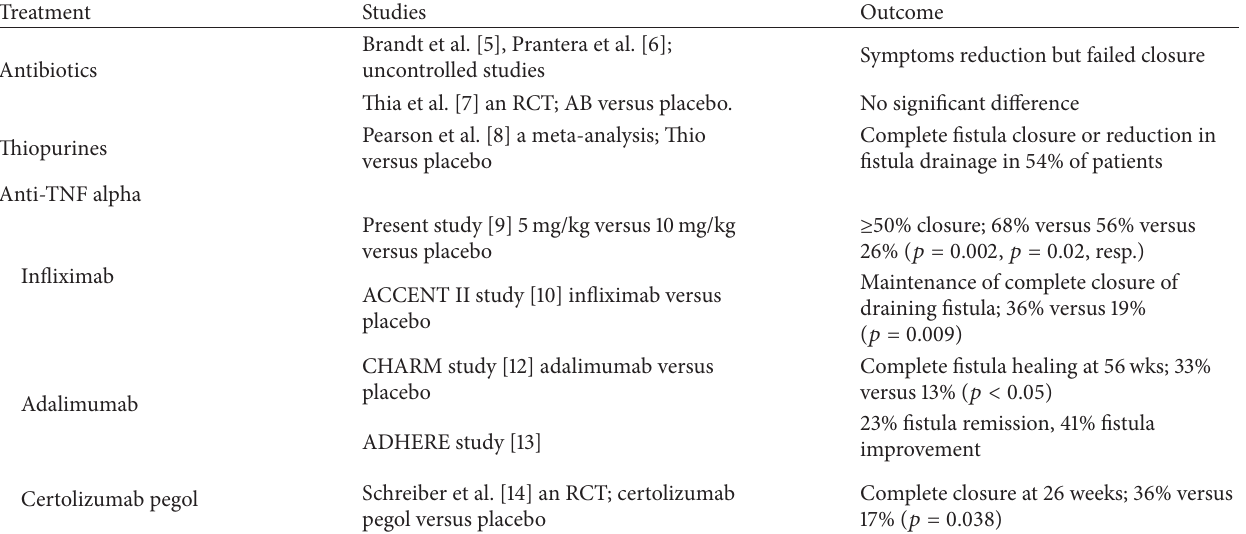
Table 1: Summary of conventional and biological medical treatments of fistulizing CD and reported